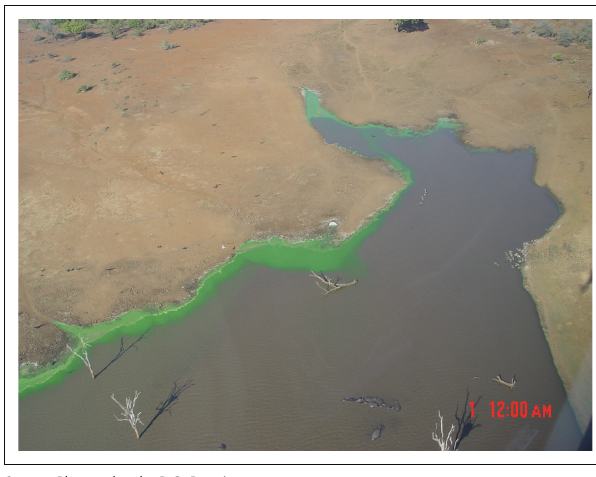
Source : Photo taken by R.G. Bengis FIGURE 6: Aerial view of wind-driven algal rafting at Nhlanganzwane Dam.